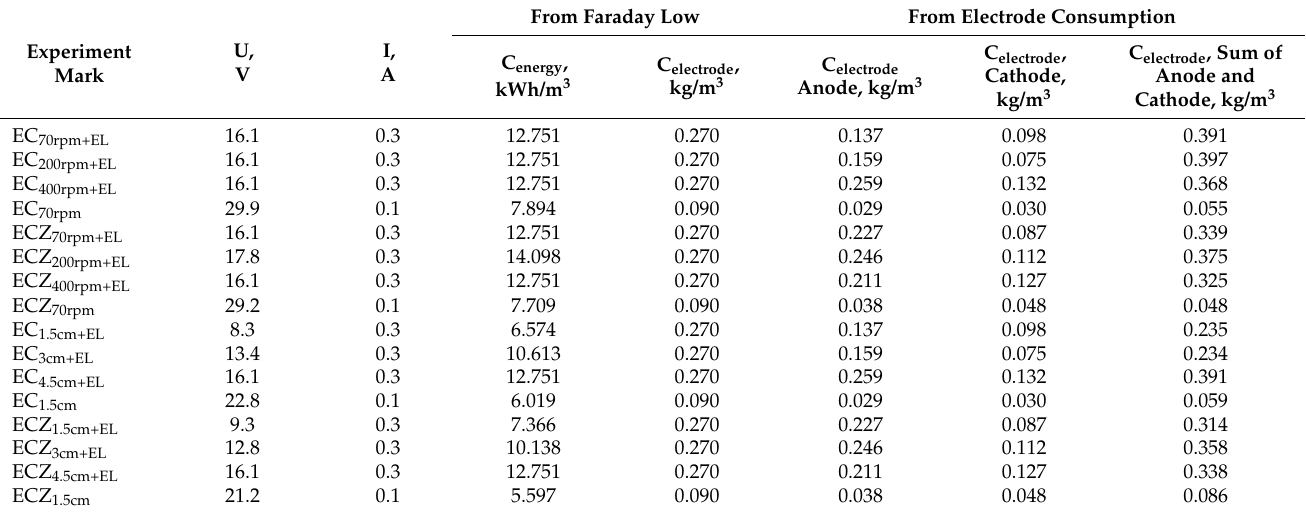
Table 6. Comparison of the electrode and electrical energy